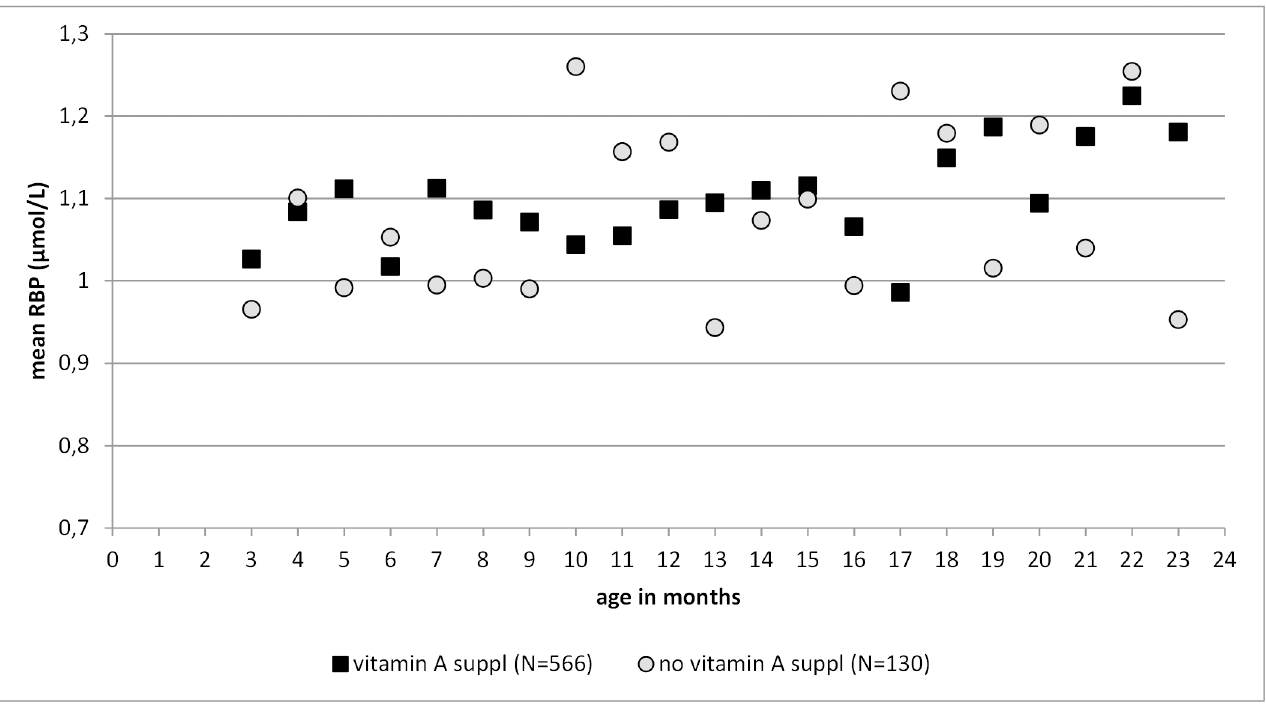
Fig 3. Mean RBP concentrations by age groups in months for children without any signs of inflammation only. 3 mo: N = 38, 4mo: N = 45, 5mo: N = 39, 6mo: N = 52, 7mo: N = 55, 8mo: N = 55, 9mo: N = 57, 10mo: N = 57, 11mo: N = 55, 12mo: N = 60, 13mo: N = 53, 14mo: N = 44, 15mo: N = 28, 16mo: N = 46, 17mo: N = 32, 18mo: N = 29, 19mo: N = 26, 20mo: N = 37, 21mo: N = 42, 22mo: N = 40, 23mo: N = 33; mo =